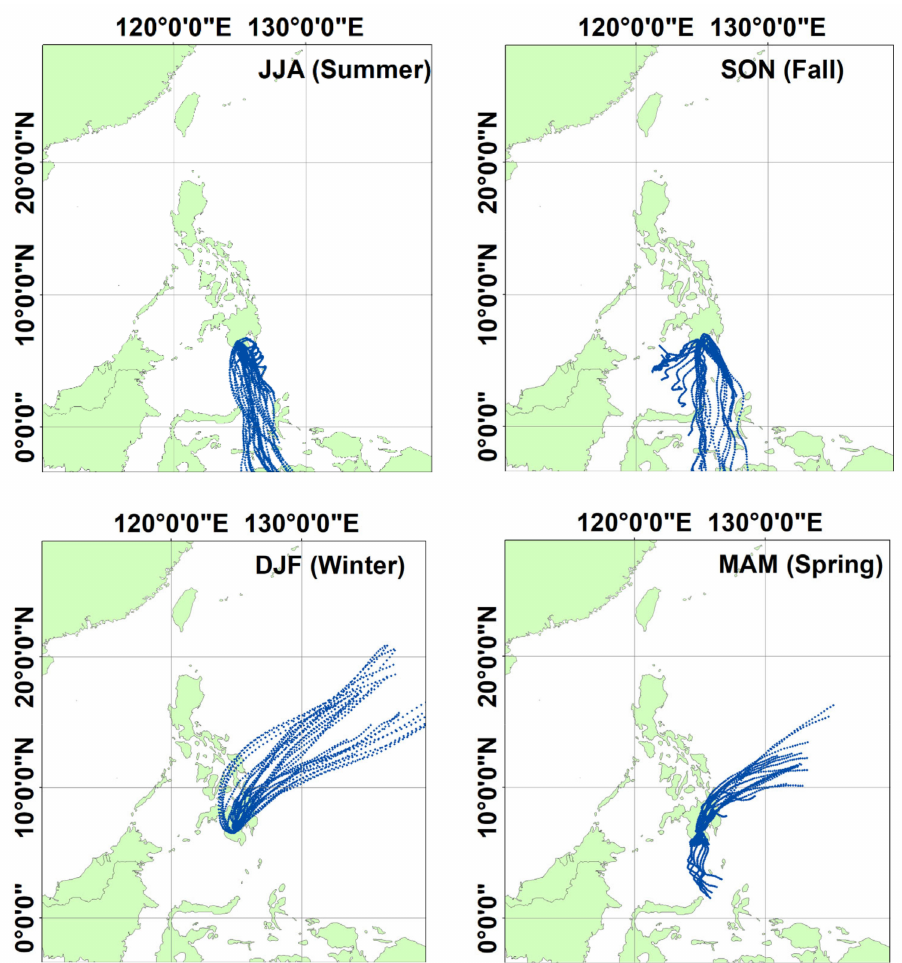
Figure 9. Cluster analysis of 72 h HYSPLIT-NCEP/NCAR wind back-trajectories arriving every 6 h for each season in Koronadal